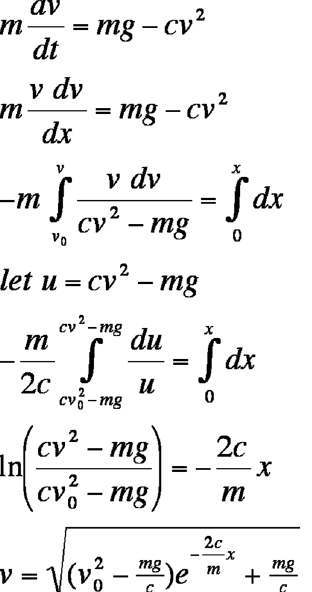
FIG. 5. Possible problem solution using the limits method. Written explanations have been omitted for brevity.